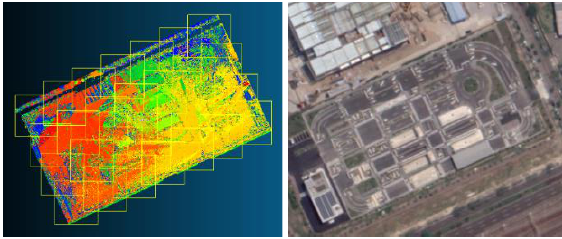
Figure 2. (Left) The entire point cloud dataset and (Right) The AV test field as seen on Google